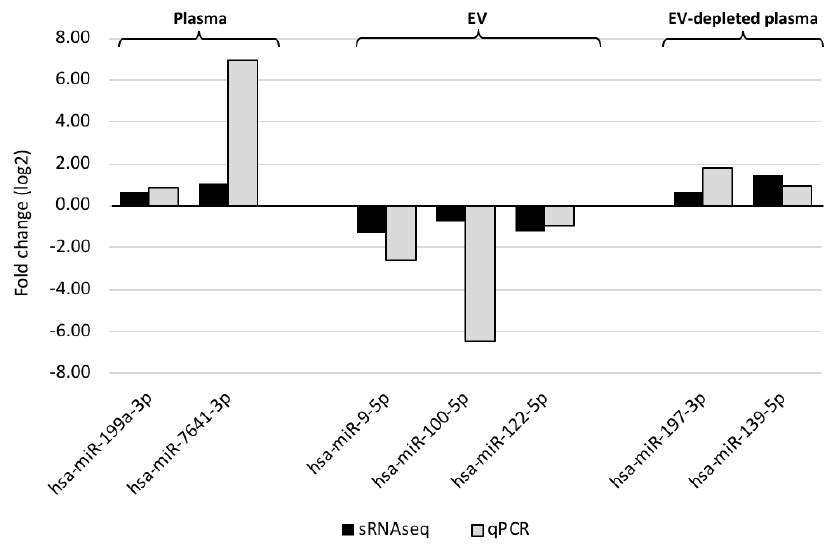
Figure 2. Comparison of miRNA concentration changes measured by qPCR (gray bars) and small RNA sequencing (black bars). The X-axis indicates the identity of a ff ected miRNA, and the Y-axis represents the fold changes in either cycle number (qPCR) or log2-transformed reads per million (RPM)-adjusted small RNAseq read counts. The sample types—whole plasma, EVs and EV-depleted plasma—are indicated on top of the